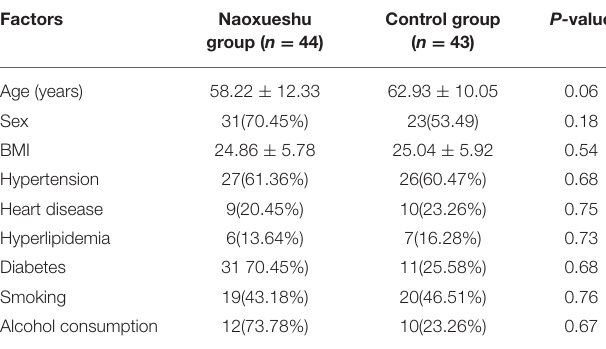
TABLE 1 | Comparison of basic information and stroke risk factors.